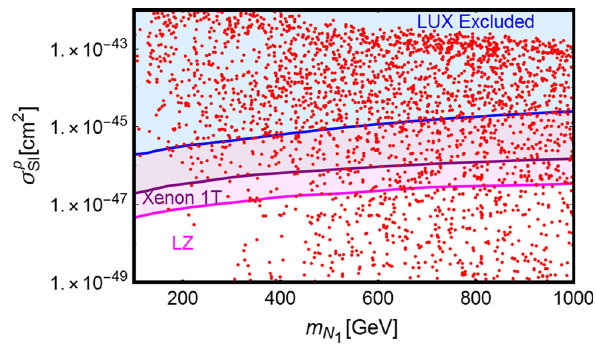
Fig. 12 Model points satisfying the correct DM relic density and pass- ing EWPT, perturbativity and unitarity constraints, in the bidimensional ,σ ) . The blue region is excluded by current limits by LUX plane ( m N SI 1 while the purple and magenta regions represent the reach of Xenon1T and